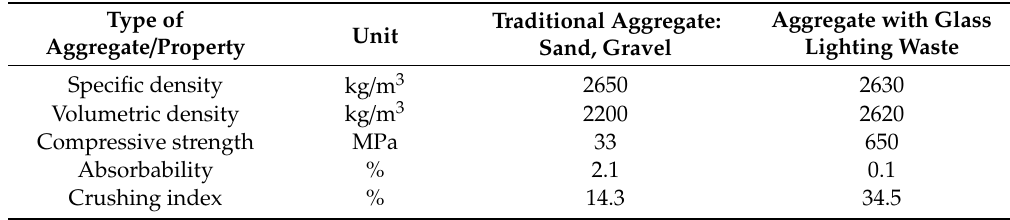
Table 1. Basic parameters of aggregates used for